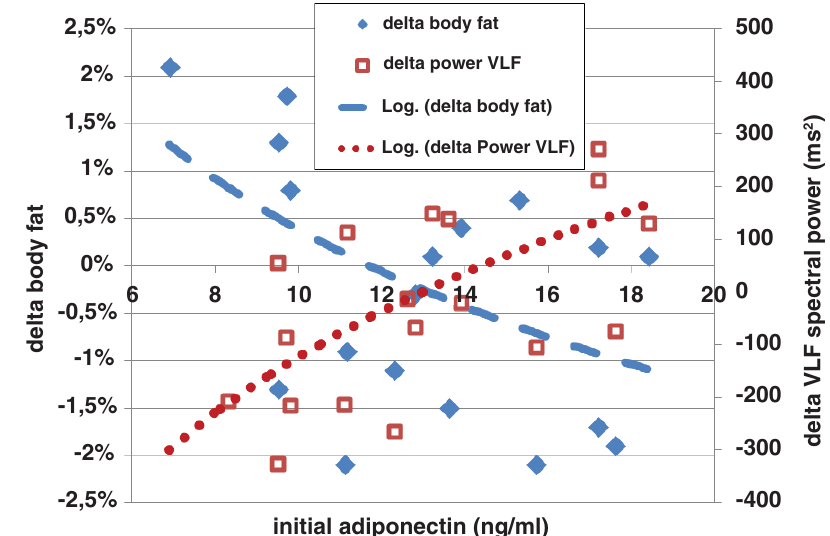
Figure 4. Significant correlations between baseline adiponectin values and immediate autonomic response at VLF band to single treatment (r=0.60, p=0.005) and between baseline adiponectin values and change of body fat percentage after series of 4 treatment sessions (r=-0.45,